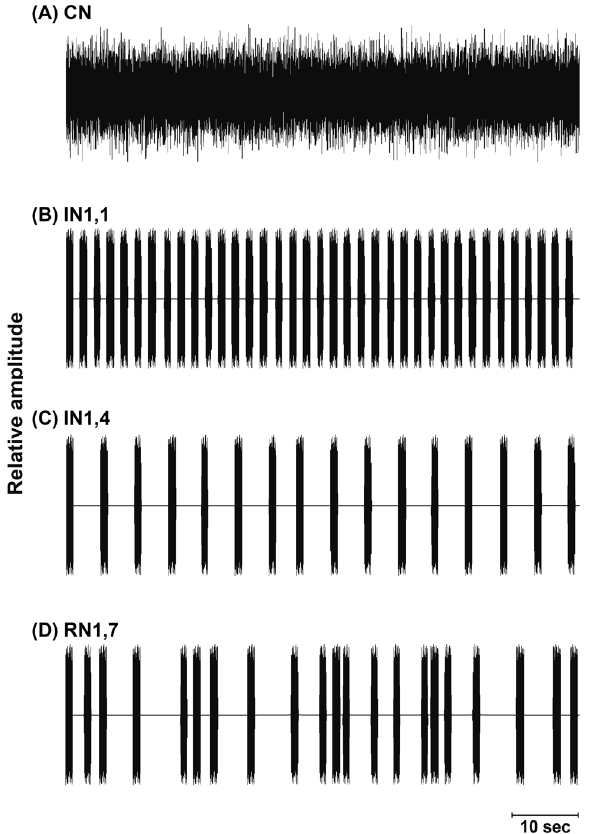
Figure 1. Acoustic treatments used in the experimental design with variable temporal patterns of white noise: ( A ) Continuous noise (CN). ( B ) Intermittent noise with 1 s noise and 1 s silent interval (IN1,1). ( C ) Intermittent noise with 1 s noise and 4 s silent interval (IN1,4). ( D ) Intermittent random noise with 1 s noise and 1–7 s silent (on average 4 s,